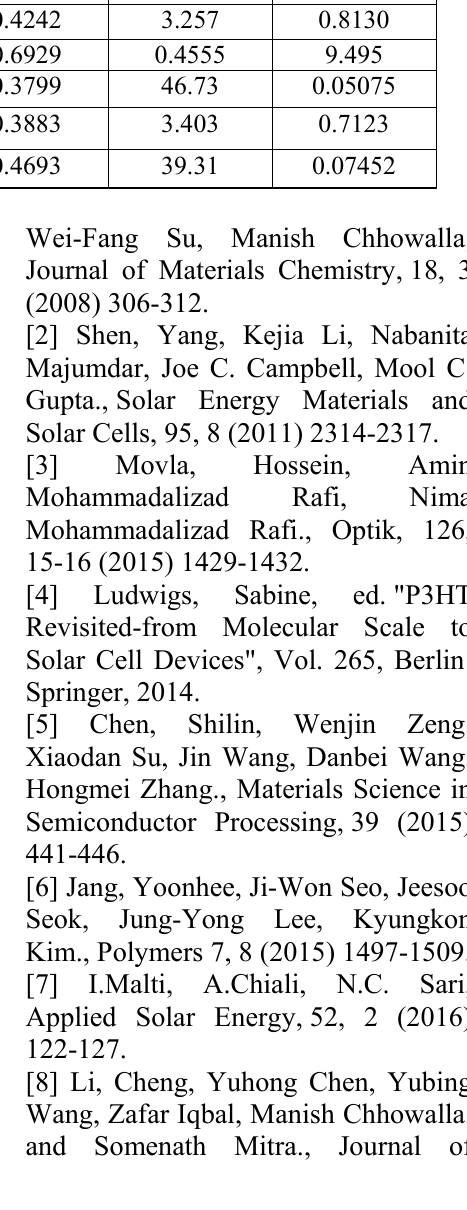
BM thin films at 61